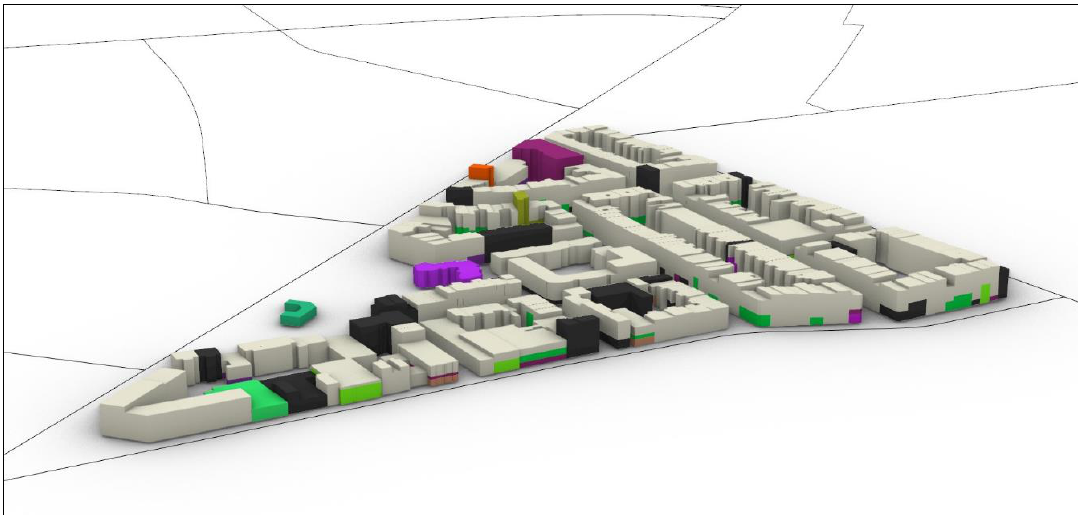
Figure 20. Example of 3D visualization of the UsageZones of the Bellamybuurt Noord neighborhood in Amsterdam. Spatial and thematic data are retrieved from the 3D city model stored in the 3DCityDB and visualized in Rhinoceros/Grasshopper.